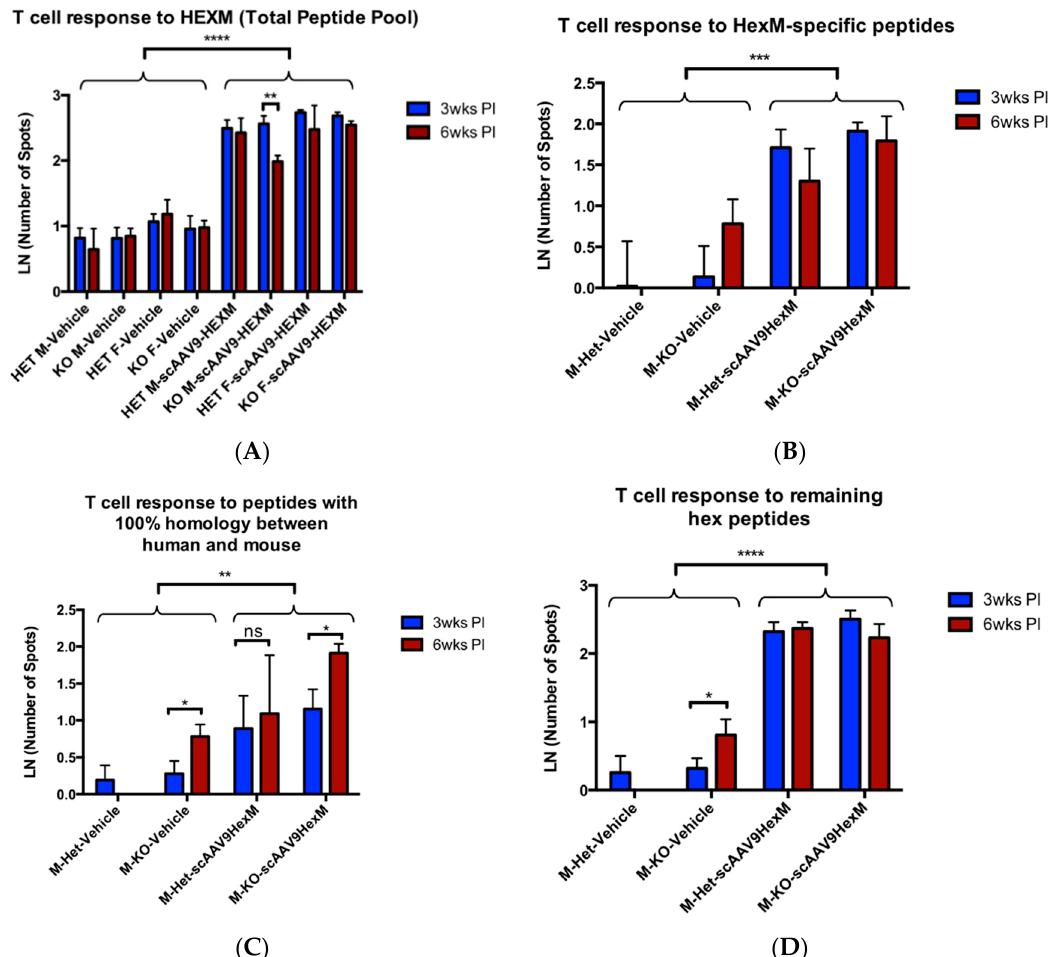
Figure 1. Hex peptide T cell responses in TSD mice. ( A ) ELISpot IFN ‐γ secretion in response to the total HexM 52 peptide pool (See Supplementary Materials) in Het and KO TSD mice 3 weeks and 6 weeks post injection (PI). HEXM ‐ treated mice showed significantly higher number of spots to HexM protein compared to vehicle ‐ treated mice (ANOVA main effect of treatment, p < 0.0001). ( B ) Comparison of IFN ‐γ secretion spots in response to novel HexM peptides (i.e., not homologous with either the mouse or human HexA) in male Het and KO TSD mice 3 weeks and 6 weeks. HEXM ‐ treated mice showed significantly higher number of spots to HexM protein compared to vehicle ‐ treated mice (ANOVA main effect of treatment, p < 0.001). ( C ) Number of spots in response to exposure with peptides with 100% homology between humans and mice in male Het and KO TSD mice 3 weeks and 6 weeks PI. HEXM ‐ treated mice showed significantly higher number of spots to HexM protein compared to vehicle ‐ treated mice (ANOVA main effect of treatment, p < 0.01), and there was a tendency for KO TSD mice to show a greater response to these peptides at 6 weeks than at 3 weeks ( p < 0.05, post hoc tests). ( D ) Number of spots in response to the HexM peptide pool specific to human HexA in male Het and KO TSD mice 3 weeks and 6 weeks PI. HEXM ‐ treated mice showed significantly higher number of spots to HexM protein compared to vehicle ‐ treated mice (ANOVA main effect of treatment, p < 0.001). In summary, both heterozygous and KO TSD mice treated with scAAV9 ‐ HexM had a T ‐ cell response to all types of peptides in the hex peptide pool. M = male, F = female, wks = weeks, PI = post injection, N per grou p = 3, error bars = SEM, **** = p < 0.0001, *** = p < 0.001, ** = p < 0.01, * = p < 0.05.